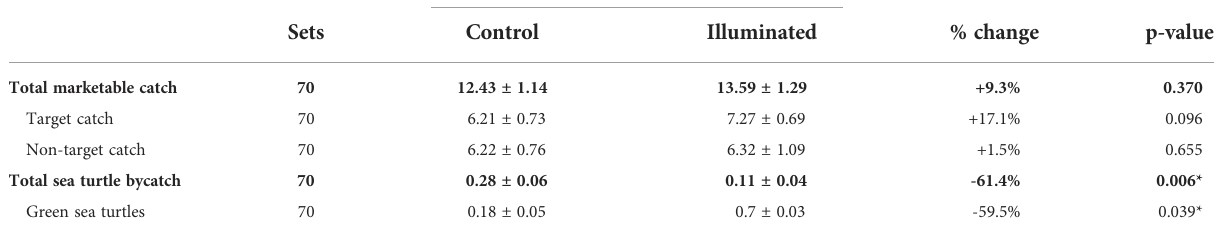
Percent change represents the difference in mean CPUE between control and illuminated nets. P-values represent the differences between control and illuminated nets analyzed using a Wilcoxon signed-rank test paired by net, with signi fi cant differences indicated with an asterisk. CPUE = number of catch per (1 km of net X 12 h), SE, standard error.